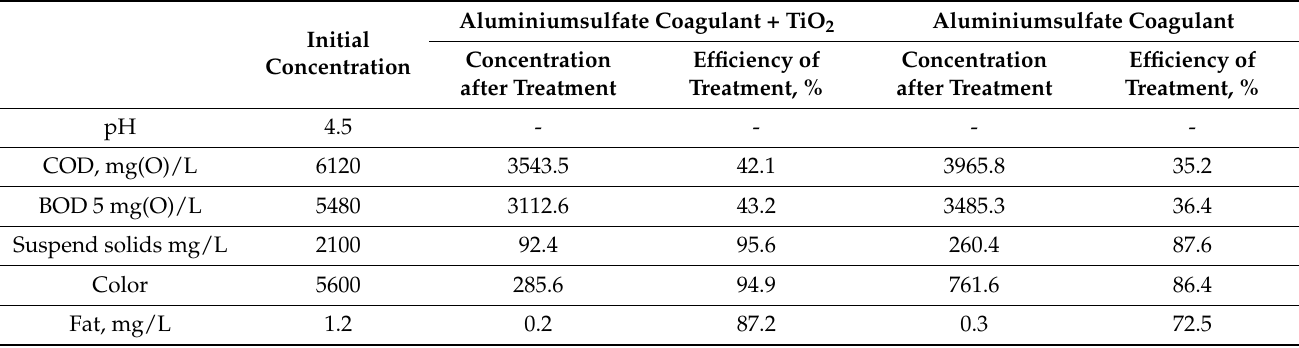
Table 2. Residual concentrations and treatment